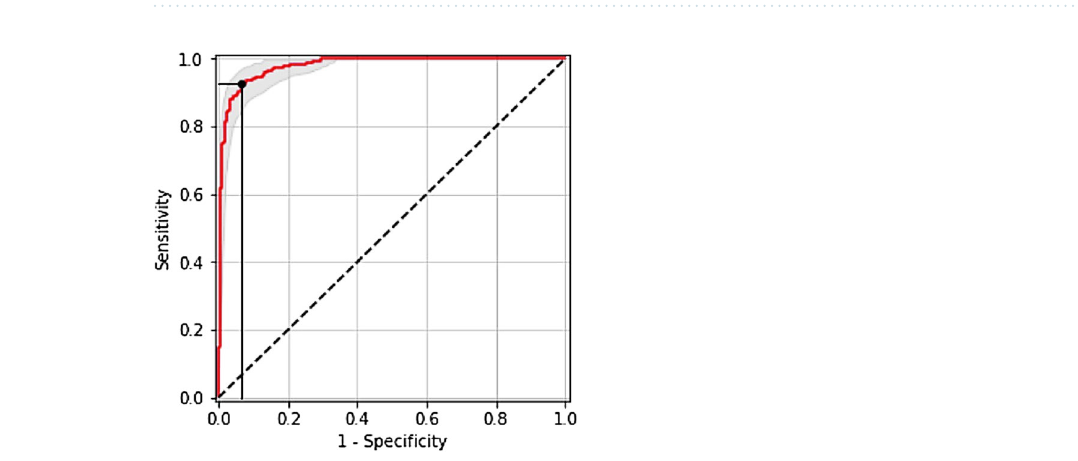
Table 1. Performance metrics for test phase with different DR classes. The bold indicate to our results that used to comparative with other studies.